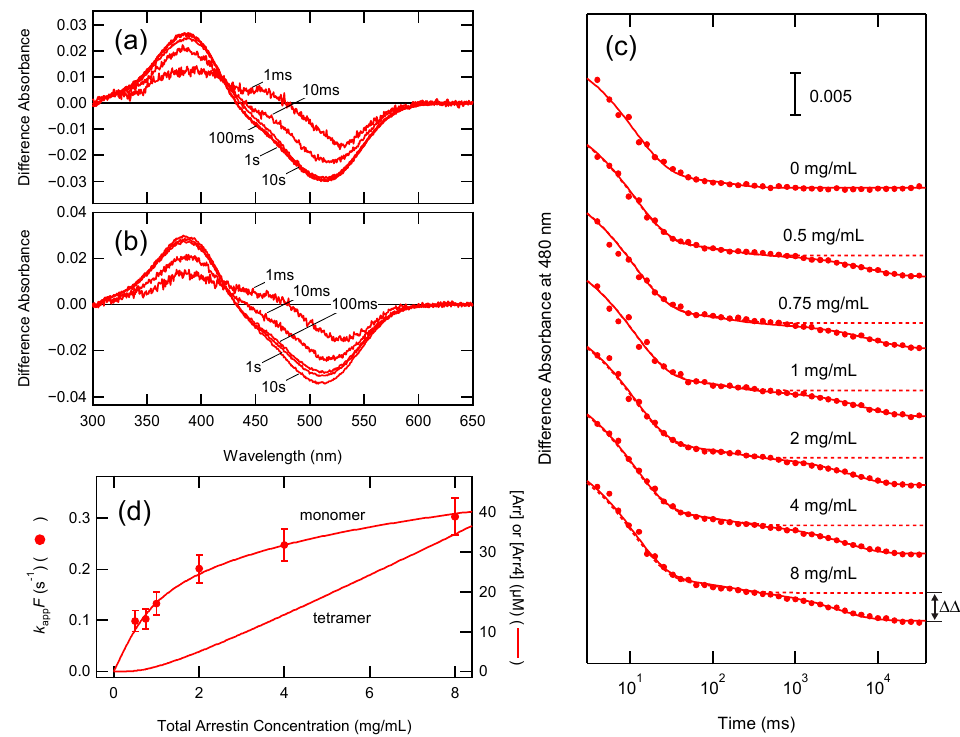
Figure 6. Extra-Meta-II formation induced by arrestin binding. Transient difference spectra after photoexcitation of rhodopsin (around 1 µM) in the (a) absence or (b) presence of 2 mg/mL arrestin were measured (transient difference spectra at 1 ms, 10 ms, 100 ms, 1 s, and 10 s are shown). (c) Changes in absorbance at 480 nm plotted against time after photoexcitation and fitted with a double- (0 mg/mL arrestin) or triple-exponential function (0.5–8 mg/mL arrestin), with the first and second components (transition from Meta-I to Meta-II) being global variables. For comparison, the fitting curve for 0 mg/mL arrestin is overlapped (dotted lines). The third component shows the formation of extra-Meta-II. The amplitude of the third component ( ∆∆(cid:1827) ) is proportional to the fraction of extra- Meta-II. (d) Rate constants for the formation of extra-Meta-II ( (cid:1863) (cid:2911)(cid:2926)(cid:2926) (cid:1832) = (cid:1863) (cid:2911) [Arr (cid:3051) ] ) are plotted against the arrestin concentration. The monomer and tetramer concentrations of arrestin based on Equation (1) are shown for comparison. P-rRh is converted to Meta-I shortly after flash excitation (< 1 ms) and then converted to Meta-II to form the equilibrium between Meta-I and Meta-II. In the absence of arrestin, this equilibrium is formed at 100 ms and stable up to 10 s (Figure 6a). While the kinetics of the formation of Meta-II are complicated due to the heterogeneity of intermediates and branched reactions [29], the absorbance change at 480 nm (the absorption maximum of Meta-I) plotted against the time after excitation was expressed using a double-exponential function (Figure 6c, top). ∆(cid:1827) (cid:2872)(cid:2876)(cid:2868) = (cid:1827) (cid:2868) + (cid:1827) (cid:2869) (cid:1857) (cid:2879)(cid:3038) (cid:3117) (cid:3047) + (cid:1827) (cid:2870) (cid:1857) (cid:2879)(cid:3038) (cid:3118) (cid:3047)